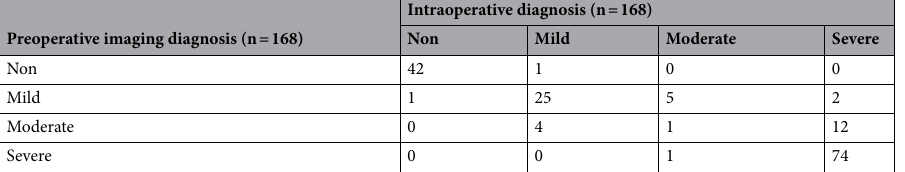
Table 3. Preoperative imaging diagnosis and intraoperative diagnosis of vascular invasion in all the 21 patients. Notes Each patient has 8 intrahepatic vessels in total, and then all patients in our cohort have 168